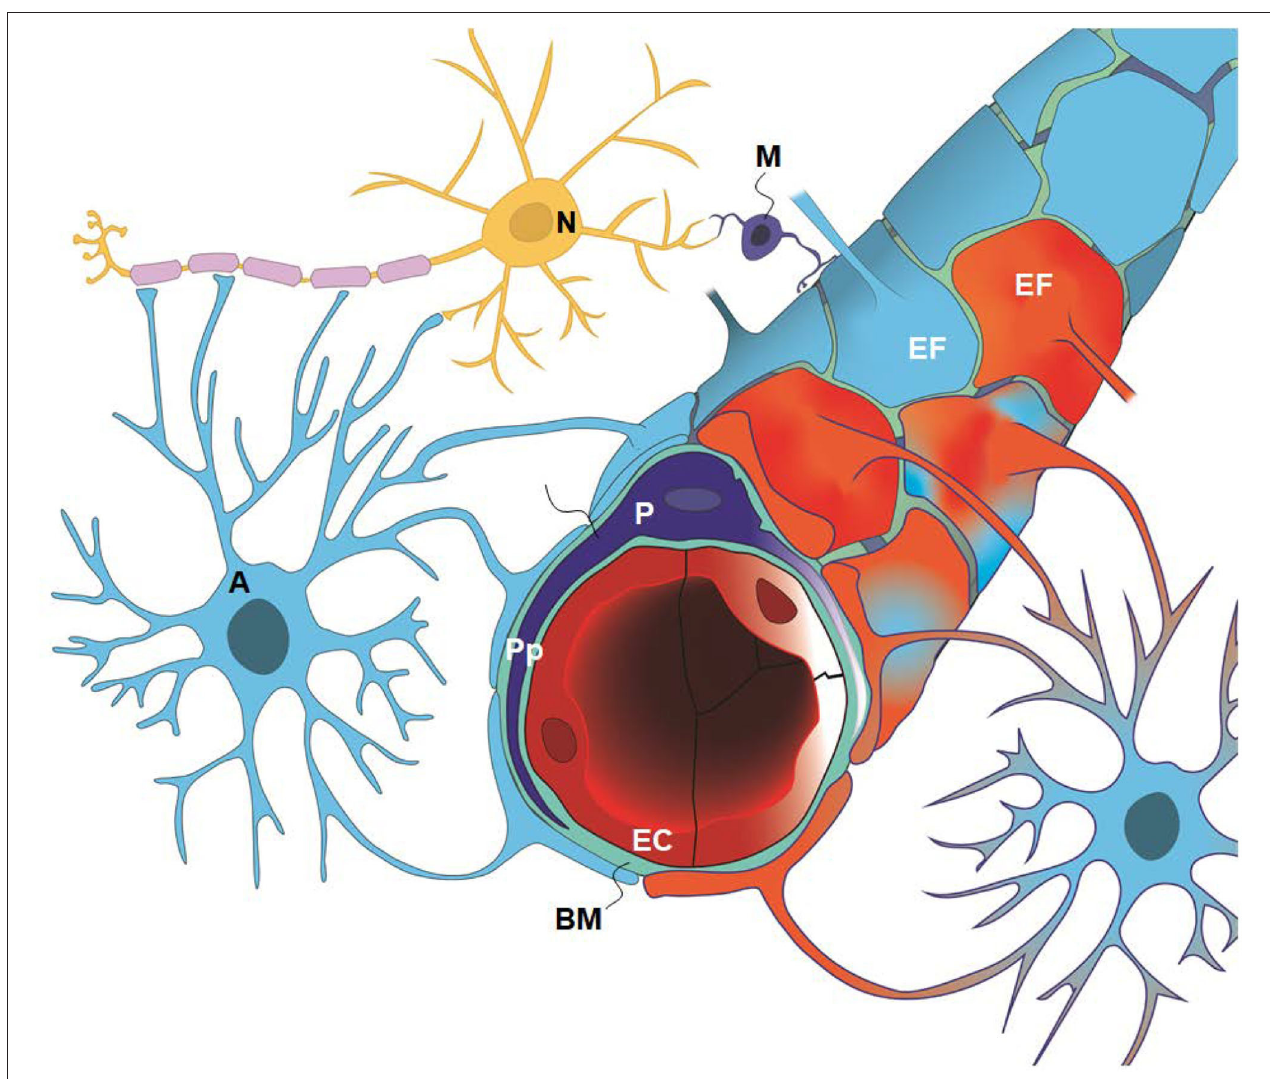
FIGURE 1 | The glia-neuro-vascular interface (also denoted the glia-neuro-vascular unit/coupling) incorporates the capillary wherein its circumference consists of endothelial cells (ECs) having tight junctions and pericytes (P) with processes (Pp). The relationship between the endothelial cells and pericytes in humans is 1:1–3:1, decreasing with age and in diseases. The basement membrane (BM) is a loose matrix between endothelial cells (ECs) and pericytes (Ps) and the astrocytic end-feet (EF). The astrocytic end-feet processes create a donut shaped structure enclosing the basement membrane (BM). There are inter-end-feet-gaps between the endfoot (EF) processes enabling passage of molecules to the interstitial tissue. Normal end-feet (EF) are indicated in blue to the left while pathological end-feet (EF) in red color to the right. Other components are the astrocytes (A), neurons (N) and microglia (M). In IIH, there is patchy astrogliosis, causing changes to the normal configuration of astrocytes. Moreover, there is loss of integrity of the BBB with degeneration of basement membrane and pericyte processes, and BBB leakage of the blood proteins fibrinogen and fibrin. Extra-vascular fibrin(ogen) is not demonstrable in normal adult brains and is prominently pro-inflammatory. Our present disclosure of blood-brain-dysfunction in IIH subjects indicates that the glia-neuro-vascular unit is likely associated with the pathogenesis of the disease. Illustration: Ine Eriksen, University of